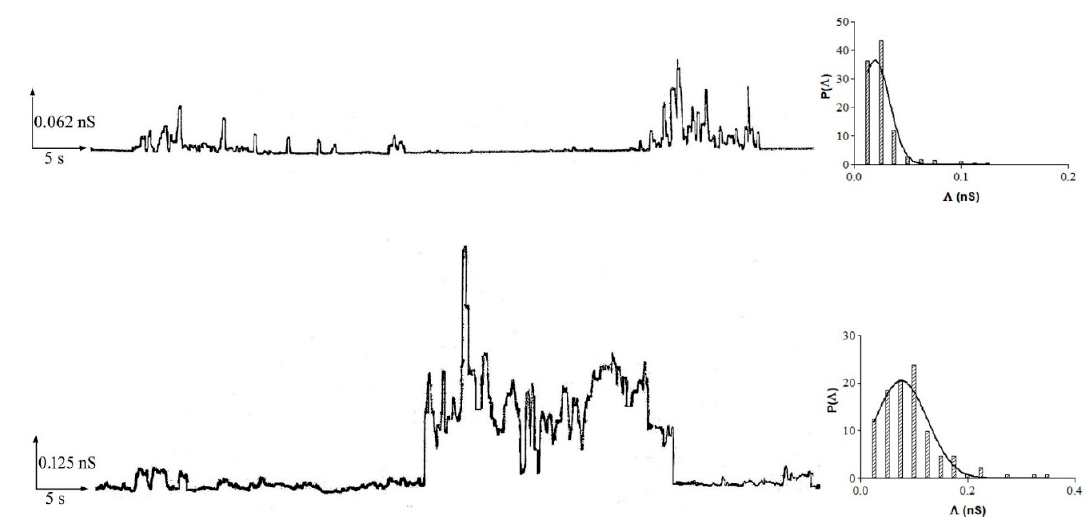
Figure 5. Resveratrol channel-like activity in POPC:Ch PLMs. Representative traces illustrating channel activity of resveratrol in membranes made up of POPC:Ch (65:35, w:w) with associated histograms of the conductance fluctuations. The histograms of the probability, P( Λ ), for the frequency of a given conductivity unit were fitted by a Gaussian which is shown as a solid curve. Experiments were performed in the presence of 10 µ M (top trace) and 20 µ M (bottom trace) of resveratrol added to the cis side, while the aqueous phase contained 0.1 M KCl (pH 7) and T = 23 ± 1 °C. Applied voltage was set to 80 mV (top trace) and 40 mV (bottom trace).